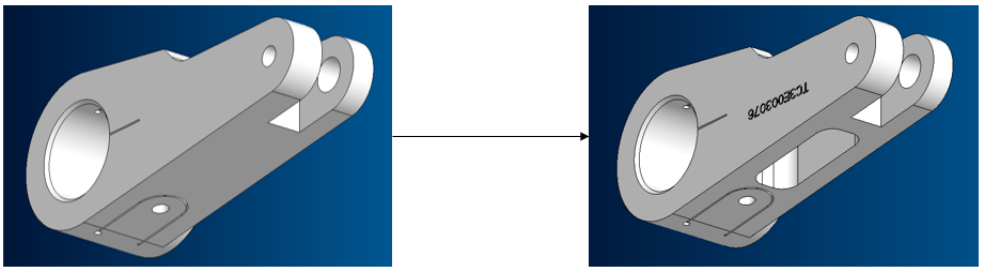
Figure 8. Example of component modifications: a milling operation is performed at the center of the components to reduce its overall mass.